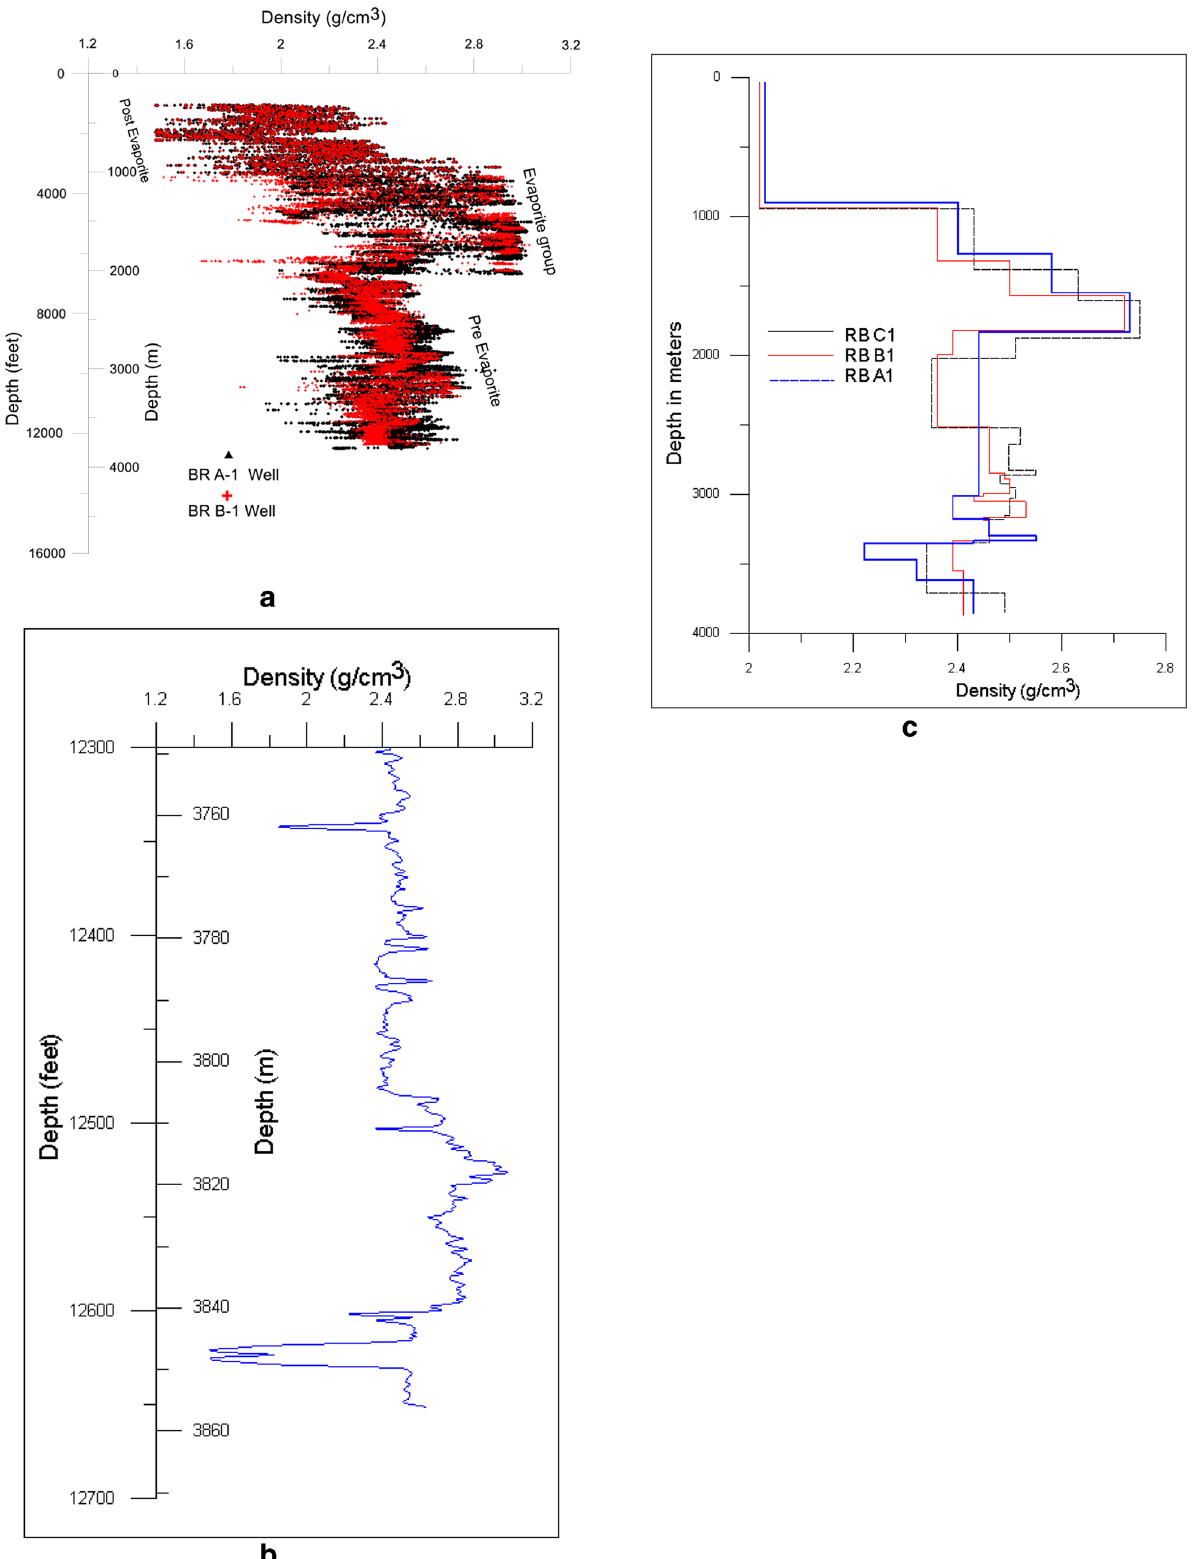
Fig. 7 a Vertical distributions of density measurements along wells RB A-1 and RB B-1. b Density log measurements of the basement rocks in RB C-1A well. c Vertical density distribution along BR A-1, BR B-1, and BR C-1A